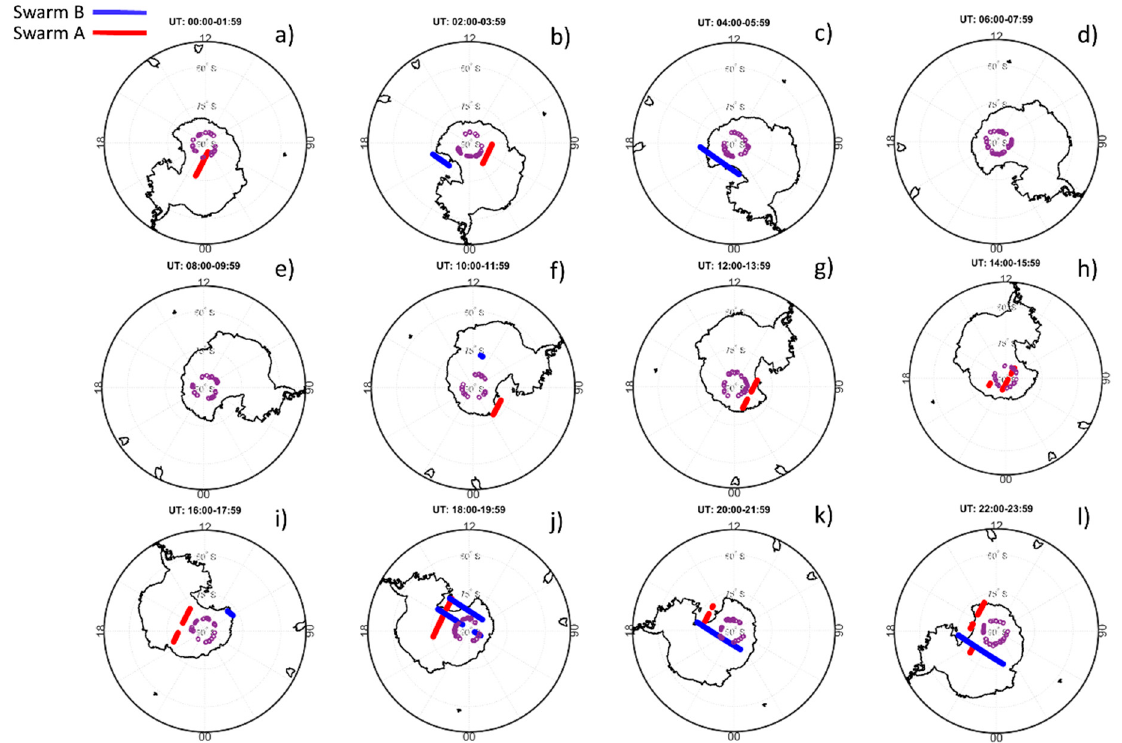
Figure 10. Polar-view maps in AACGM latitude and MLT coordinates displaying the different from zero values of the PCP flag estimated by Swarm A (red) and Swarm B (blue) data on 8 September 2017. In each map the projection to 350 km of altitude of all the σ φ values recorded by the GNSS receiver located at Concordia, which have elevation angle α = 30° (purple circles) are also shown to highlight the receiver’s field of view. Each map reports the observations collected in the time interval displayed on the top of each map. Each map covers 00:00–24:00 MLT and |50°|–|90°| AACGM Lat, the magnetic noon/midnight is at the top/bottom.